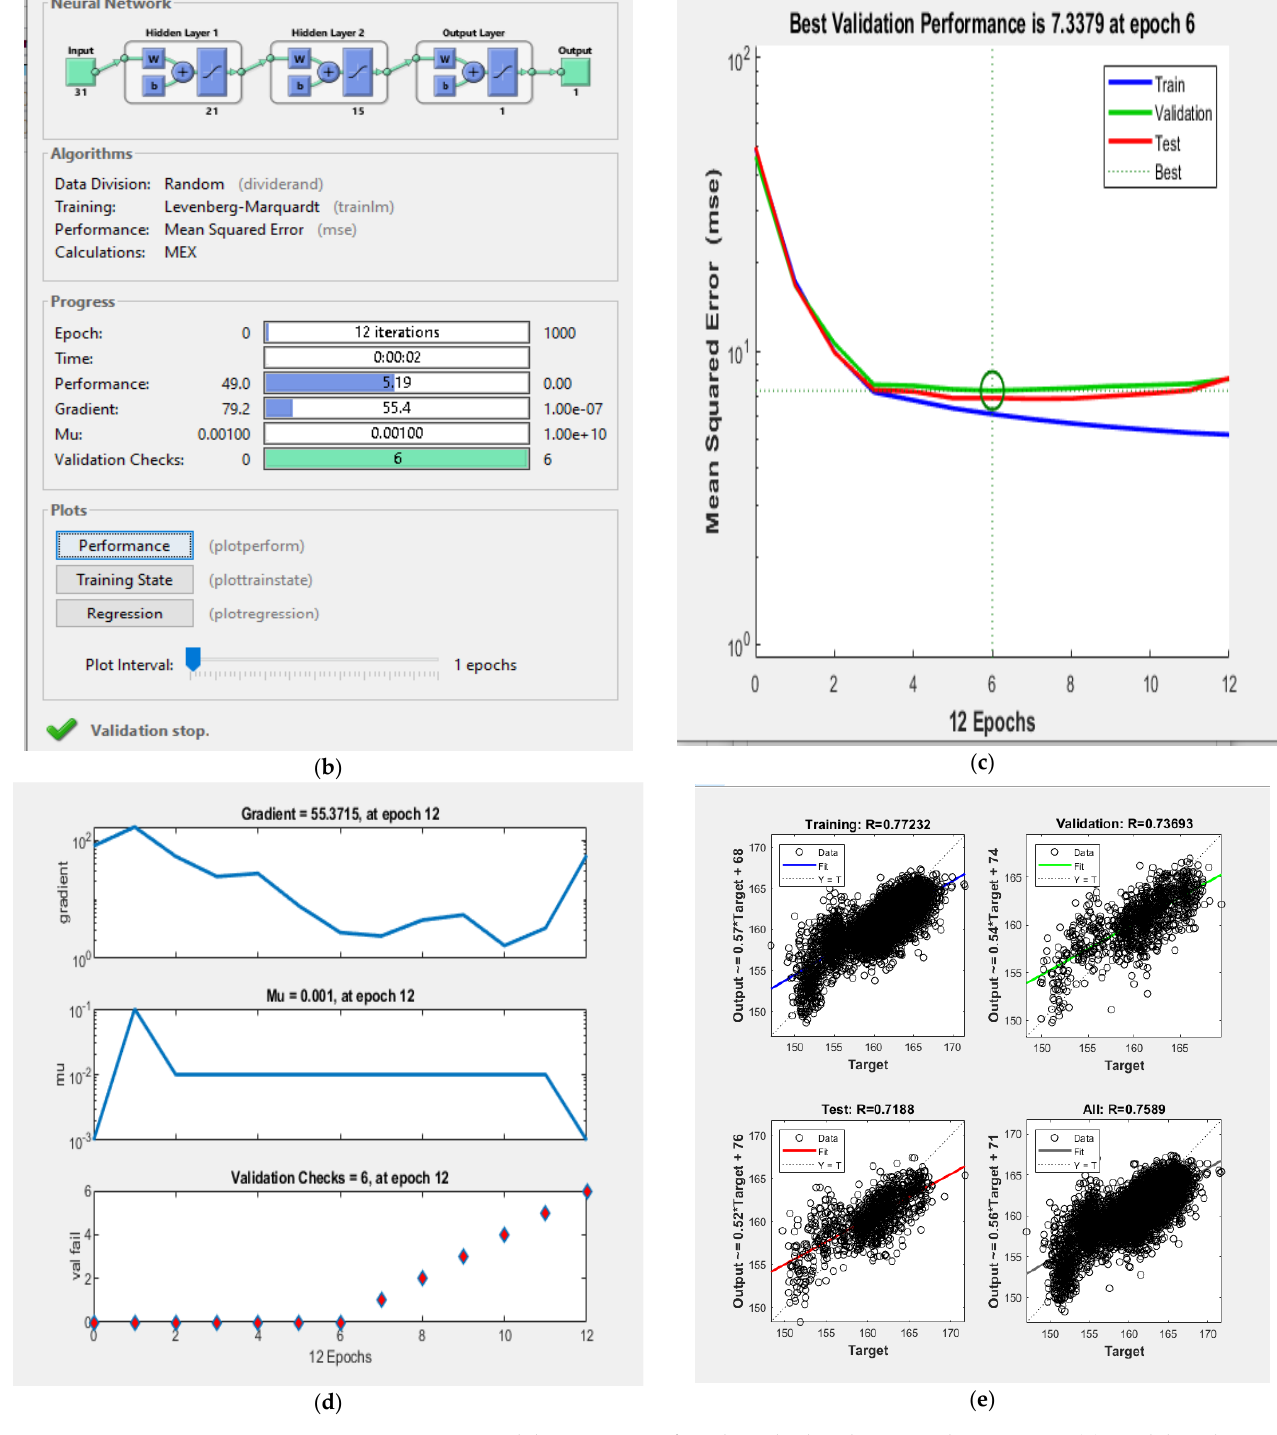
Figure 4. ANN Model in MATLAB for Ghaziabad and surrounding regions: ( a ) Model Architecture; ( b ) Model Parameters, ( c ) Model training performance, ( d ) Training state of Model and ( e ) Regression plots for target vs. output values.